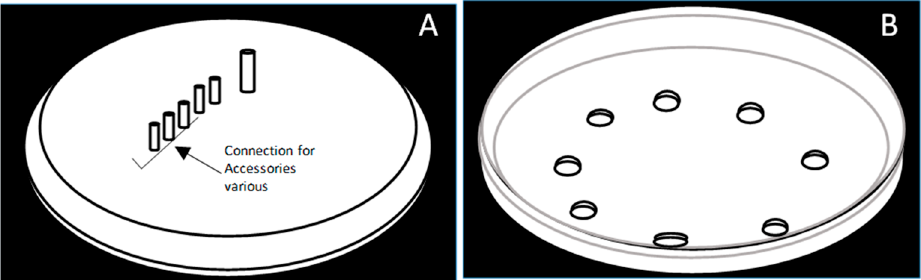
Figure 10. The upper side of the Dome ( A ), the Lower side of the Dome ( B ).